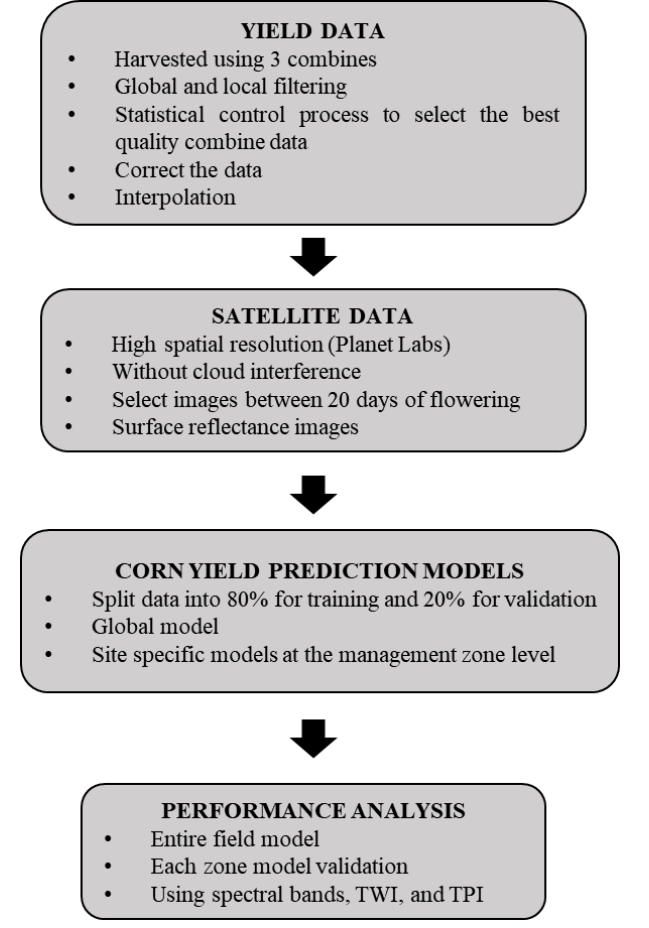
Figure 6. Theoretical framework to illustrate the approach developed in this research to predict corn yield.